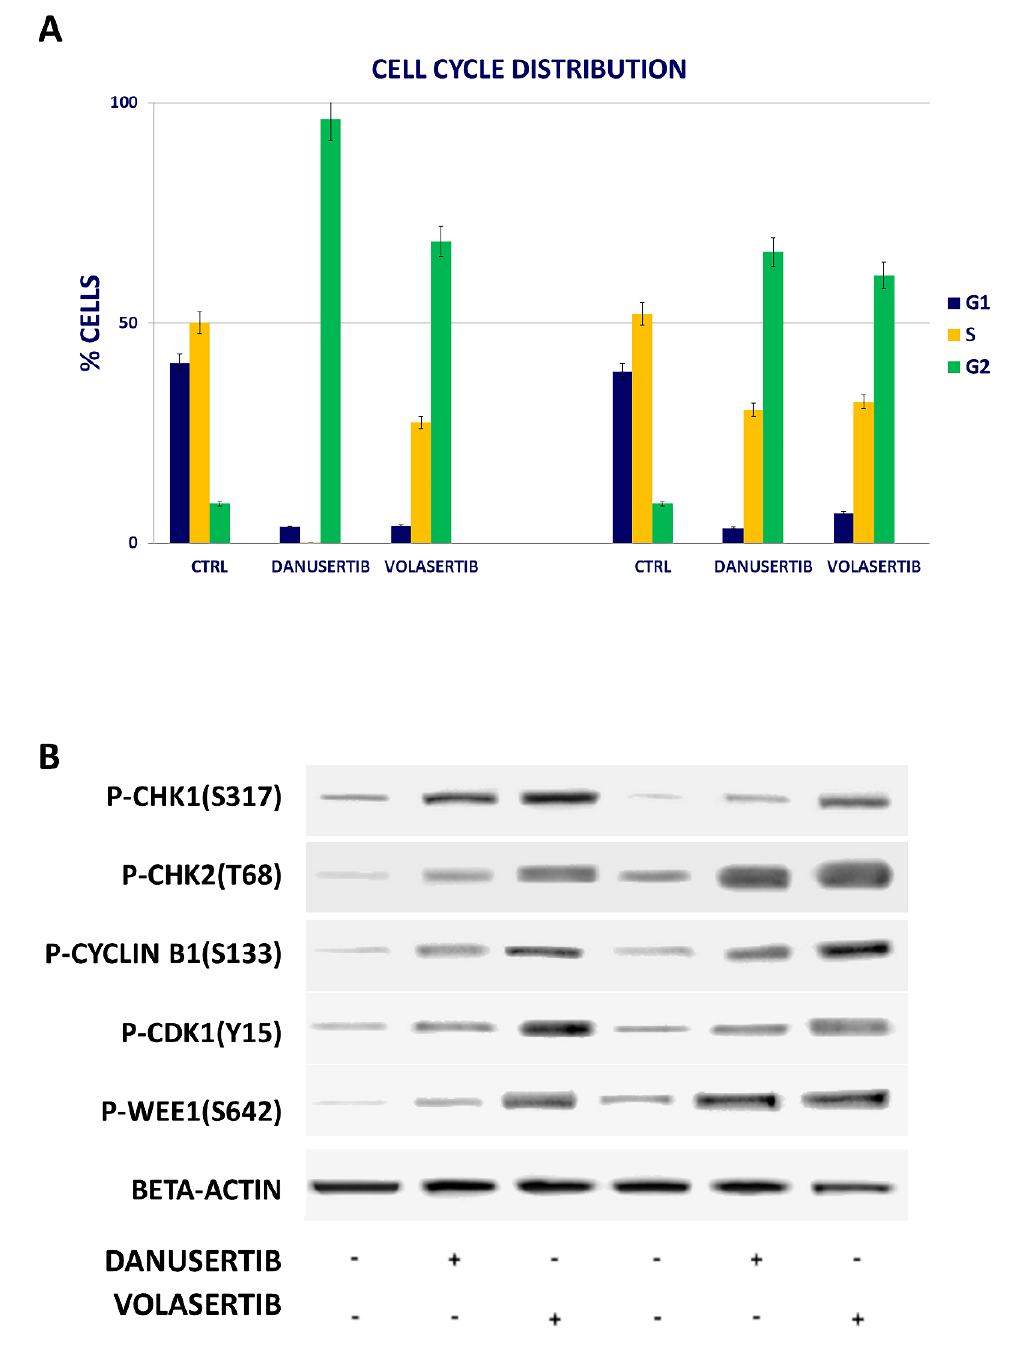
Figure 2. Effects of AKA and Plk1 inhibition on cell cycle. ( A ) Flow cytometry analysis of cell cycle was performed by using HMC-1.1 and HMC-1.2 cell lines treated with 100 nM danusertib or volasertib for 24 h. ( B ) Western blot analysis of cell cycle-related proteins in HMC-1.1 and HMC-1.2 treated with 100 nM danusertib and volasertib for 24 h (the sign + indicates samples treated with above mentioned drugs, while the sign − indicates samples cultured without the mentioned drug). Beta-actin was used as loading control. Cell cycle distribution assays were represented as a mean of three biological replicates. Similarly, all Western blotting assays were performed starting from lysates obtained by three independent drug treatments for each sample.